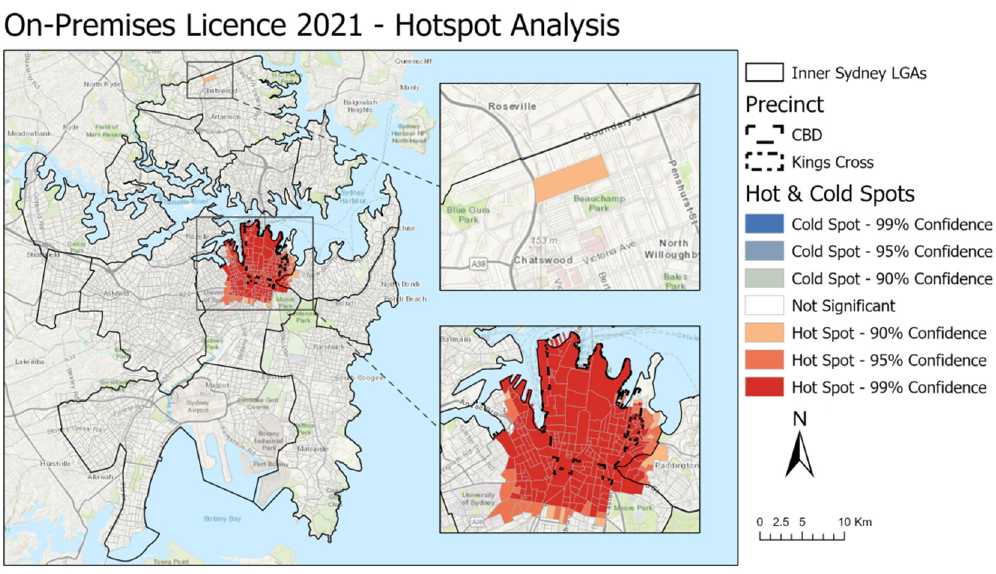
Figure 11. On ‐ premises licence hotspots 2021. Figure 11. On-premises licence hotspots 2021.